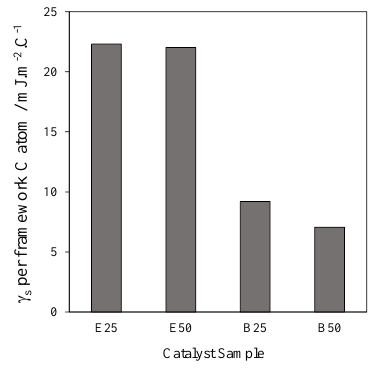
Figure 6. CH 2 and CH normalized dispersive surface energies for ethyl (E25 and E50) and phenyl (B25 and B50) substituted PMO – SBA materials showing ethyl groups have a stronger influence on dispersive surface energy per CH 2 unit than the corresponding CH sites in aromatic framework substituents. Adapted from Reference [59]; copyright (2012) with permission from Elsevier.